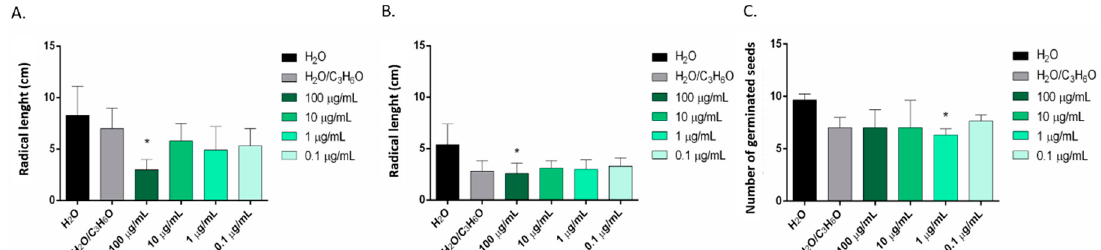
Figure 6. Phytotoxic activity of the EOs of C. limon against radical elongation of S. lycopersium ( A ), L. sativum ( B ) and germination of R. sativus ( C ), 120 h after sowing. Results are the mean of three experiments ± standard deviation. * p < 0.05 compared with control (ANOVA followed by Dunnett’s multiple comparison test).